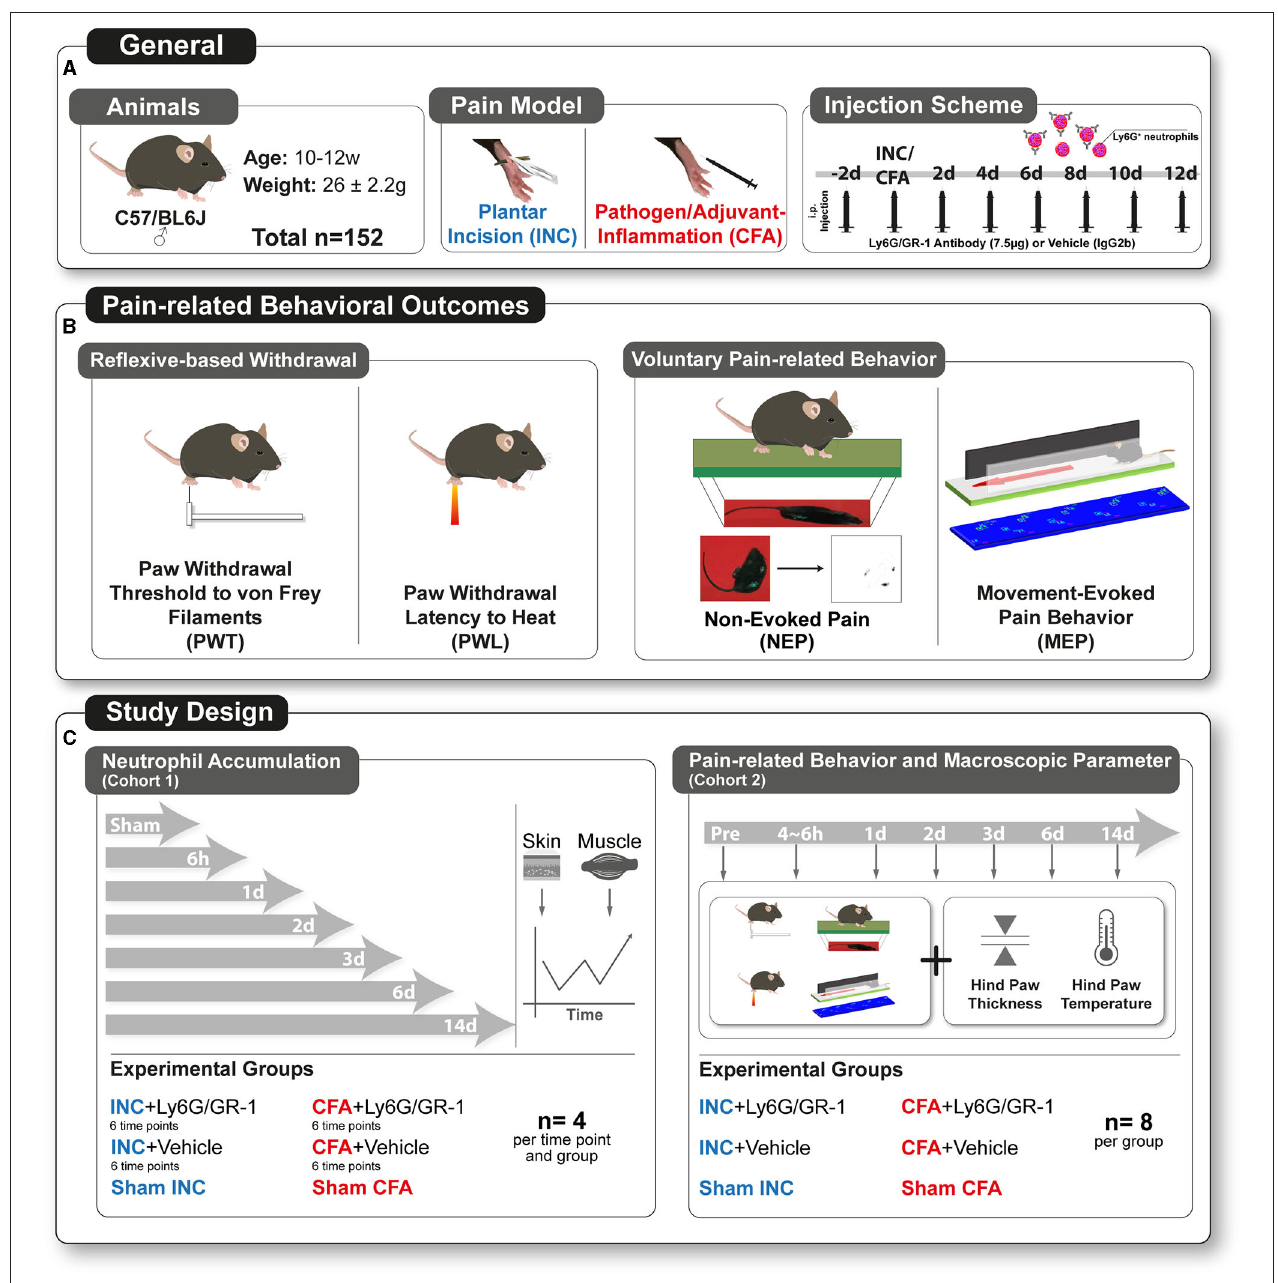
FIGURE 1 | Study design. (A) Male C57/BL6J mice (age 10–12 weeks, weight 26 ± 2.2g [mean ± SD)] were used. In this study, the plantar incision model (INC) as a surrogate for incisional pain, and the pathogen/adjuvant-induced inflammation (CFA) model as a surrogate for inflammatory pain were employed. To assess the role of Ly6G + neutrophil granulocytes (NGs), mice were treated with intraperitoneal (i.p.) injection of Ly6G/GR-1 antibody (7.5 µ g) or control antibody (IgG2b) every other day, starting 2 days before pain model induction (INC/CFA) to systemically deplete NGs. (B) Multidimensional pain-related behaviors were subgrouped into reflexive-based withdrawal, including punctate mechanical paw withdrawal threshold (PWT) to mechanical stimuli and paw withdrawal latency (PWL) to heat stimuli, and voluntary pain-related behavior, including non-evoked pain (NEP) and movement-evoked pain (MEP) behavior. (C) Mice of cohort 1 were deployed to study NGs accumulation in the skin and muscle of the plantar aspect of the right hindpaw at different time points. The characterization of the trajectories of multidimensional pain behavior and macroscopic parameters of the inflammatory response were assessed in a time-dependent manner with cohort 2. Mice from cohorts 1 and 2 were studied at different time points in relation to pain model induction. The neutrophil and antibody illustrations were created by modifying images purchased in the PPT Drawing Toolkits-BIOLOGY Bundle from Motifolio. All other illustrations were created by the authors themselves.